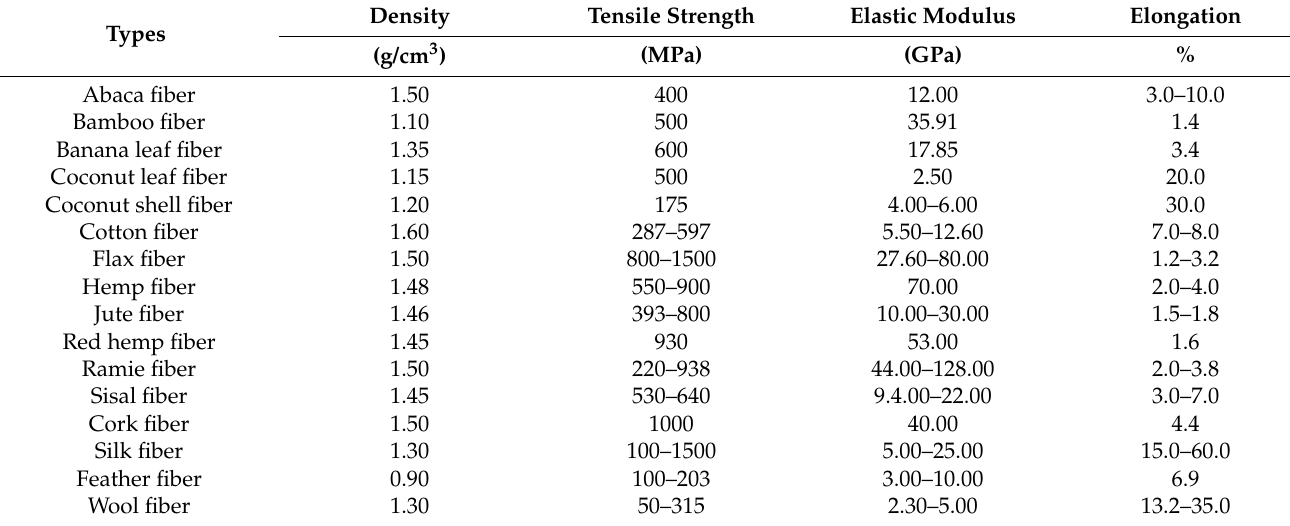
Table 5. Basic mechanical properties of natural fibers [95]. Figure 10. The general process of surface treatment of plant fibers.